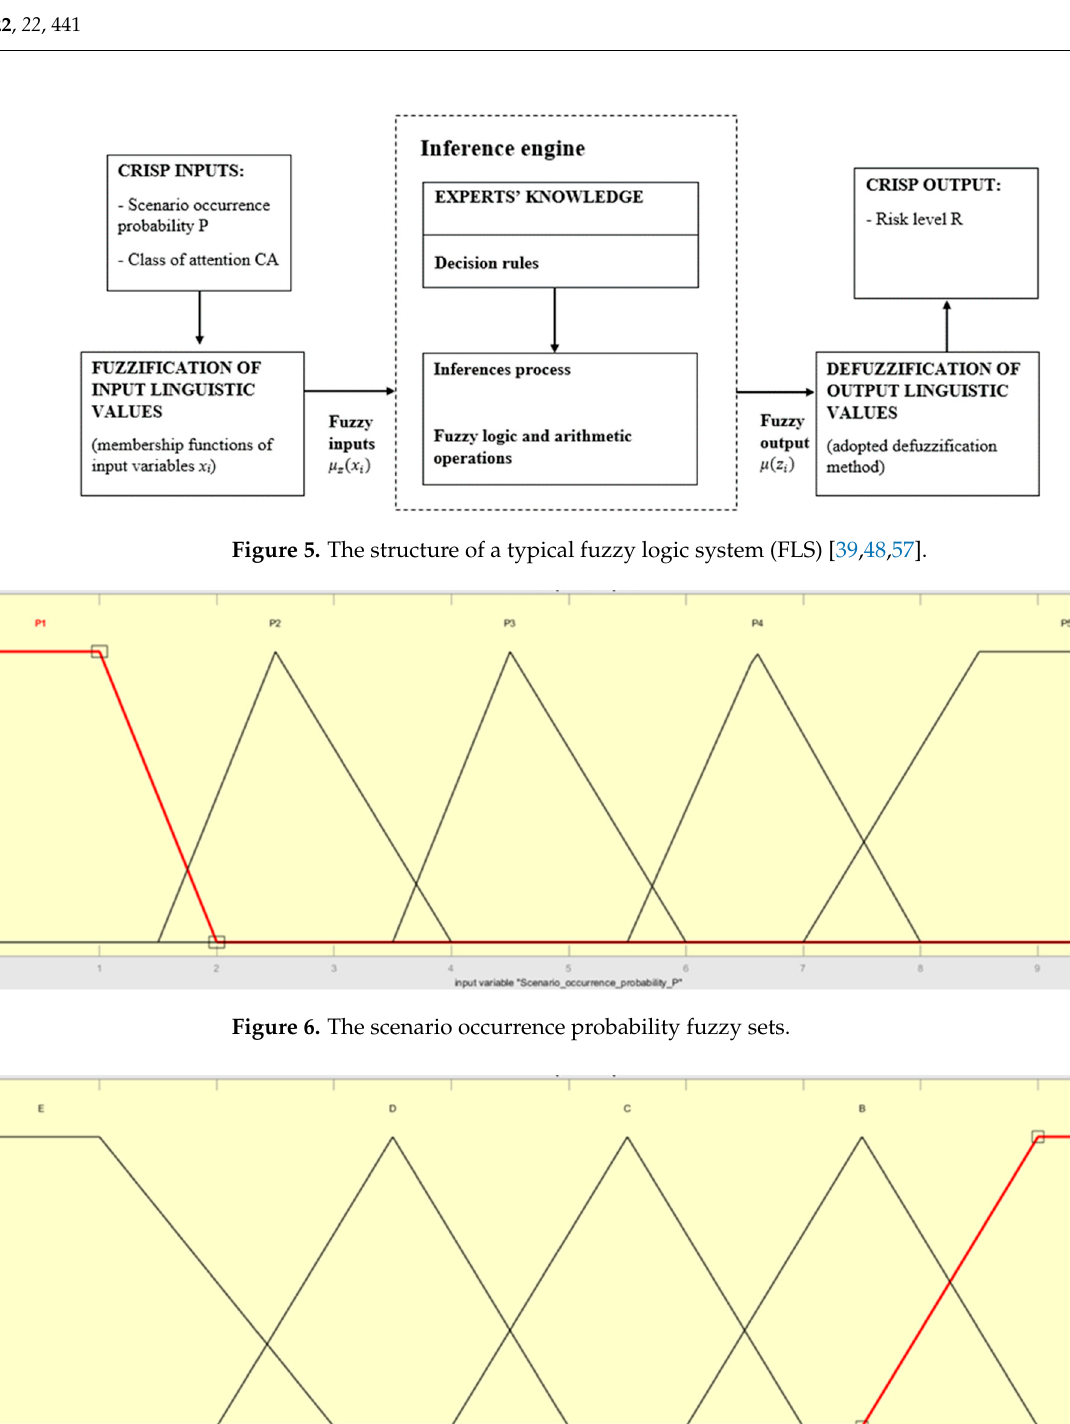
Figure 6. The scenario occurrence probability fuzzy sets.